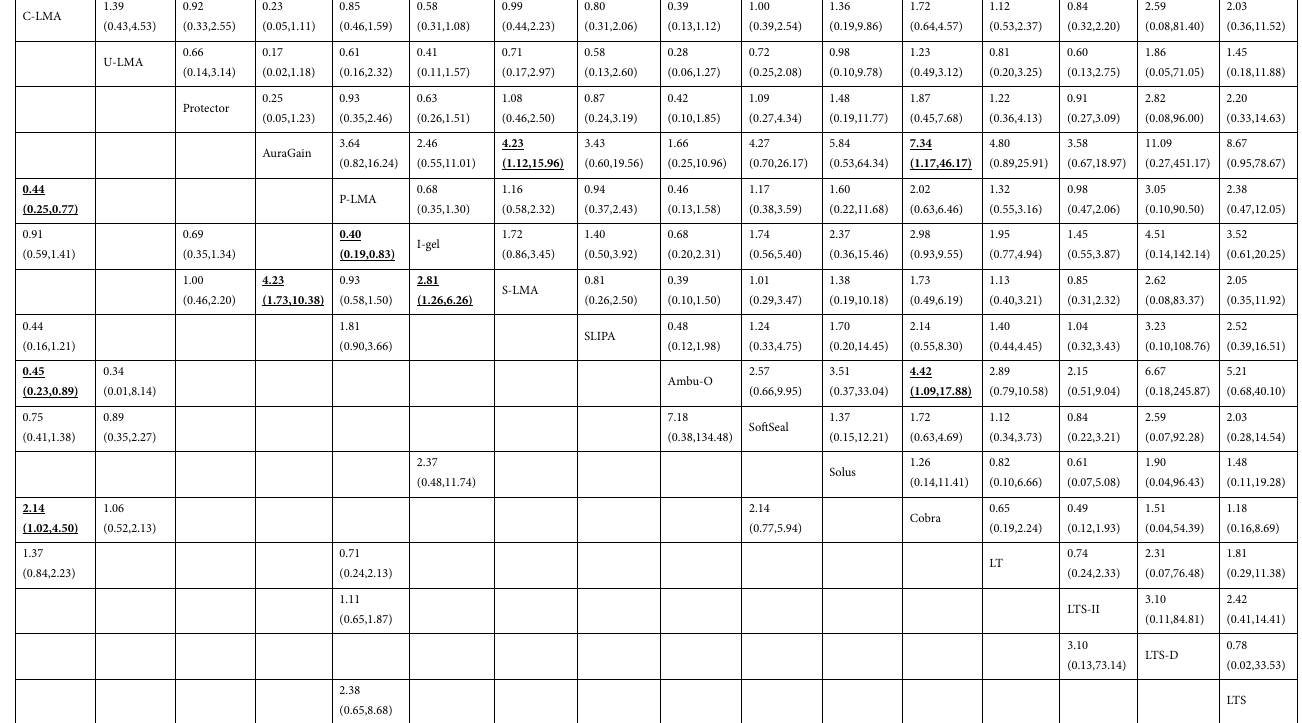
Table 4. Results for postoperative sore throat rate from network meta-analysis and pairwise meta-analysis. The device in column one is the index device and that in row one is the comparator. The device in the column one is divided by the device in the row one equals risk ratio, which did not have unit. Bold and underscored means significance. The significance means the confidence interval not containing the “1”. C-LMA, LMA Classic; U-LMA, Unique LMA; Protector, LMA Protector Airway; AuraGain, Ambu AuraGain Disposable Laryngeal Mask; P-LMA, Proseal LMA; I-gel, I-gel supraglottic airway; S-LMA, Supreme LMA; SLIPA, Streamlined Liner of the Pharynx Airway; Ambu-O, Ambu AuraOnce; SoftSeal, The Portex Soft Seal Laryngeal Mask; Solus, Solus Standard Laryngeal Mask Airway; Cobra, Cobra Perilaryngeal Airway; LT, Laryngeal Tube; LTS II, Laryngeal Tube Suction II; LTS-D, Laryngeal Tube Disposable; LTS, Laryngeal Tube